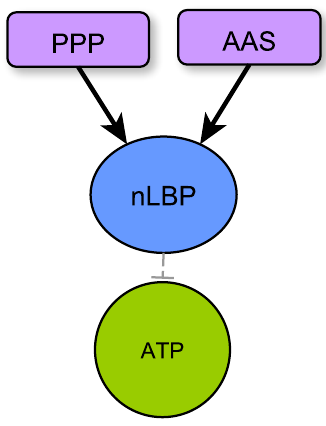
Figure 7. resources and target for nLBP